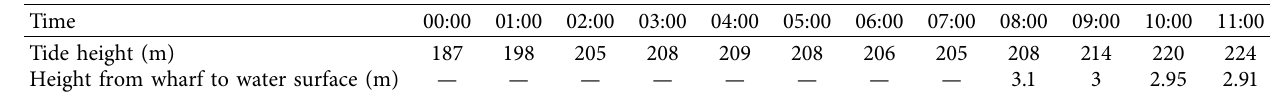
Table 8: Tide report (from 00:00 to 11:00).